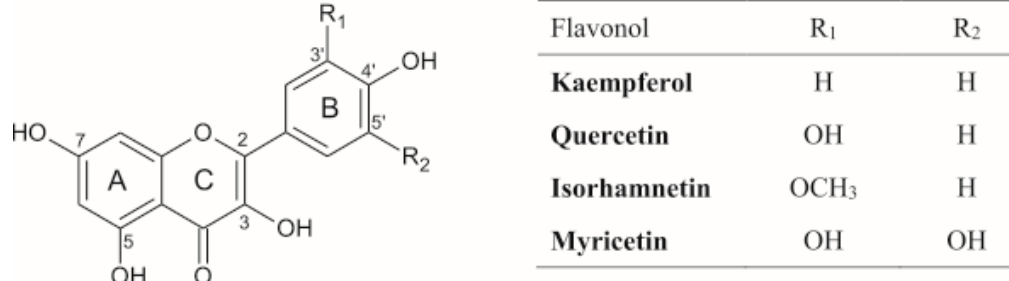
Figure 1. Structures of kaempferol, quercetin, isorhamnetin, and myricetin .